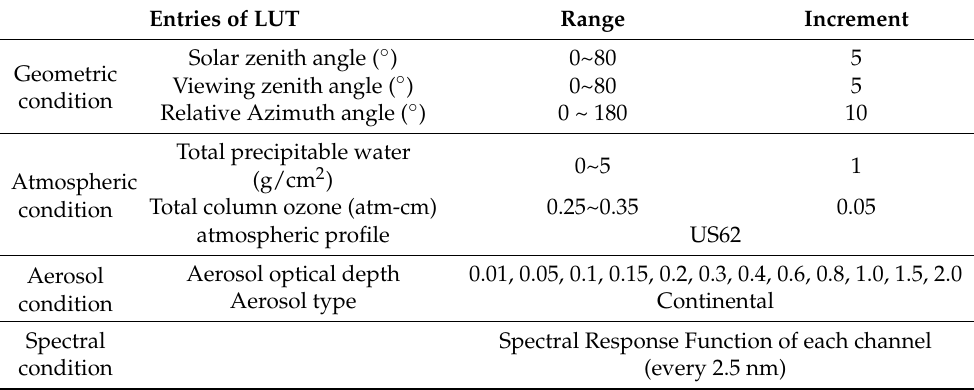
Table 3. The entries for preconstruction of 6SV LUT. Entries of LUT